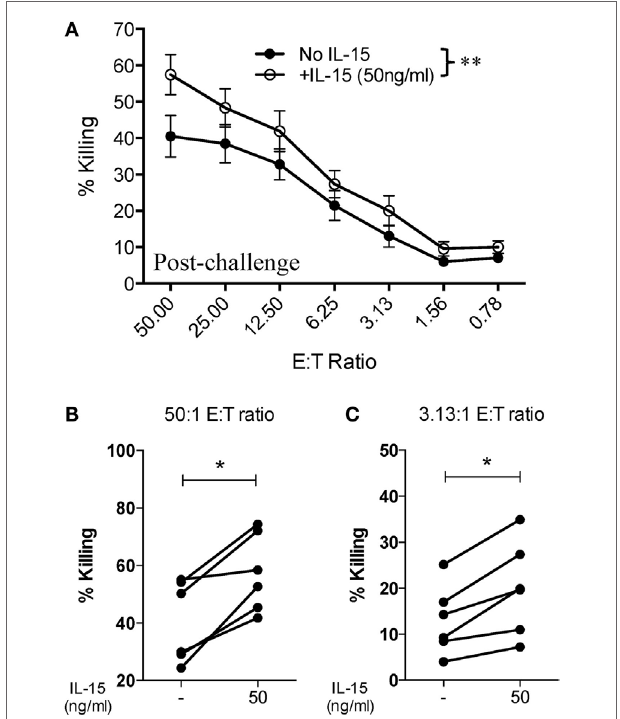
FigUre 4 | higher dose of il-15 pre-treatment is required to improve cytotoxic potential of nK cells from siV-infected macaques . Frozen PBMCs obtained from six macaques at 8 or 12 weeks post-challenge were thawed and cultured overnight in media alone or in media supplemented with 50 ng/ml of recombinant rhesus macaque IL-15 before being used in 721.221 killing assays. (a) Killing of 721.221 target cells by PBMCs from SIV-infected macaques pre-cultured with or without 50 ng/ml of IL-15. Data reported are means ± SEM. ** p < 0.01 indicates statistically significant differences between the indicated killing curves as determined by two-way ANOVA. (B,c) Impact of 50 ng/ml IL-15 pre-treatment on 721.221 target cell killing at either a high [50:1 (B) ] or low [3.13:1 (c) ] effector-to-target cell ratio. * p < 0.05 indicates statistically significant differences between the two compared conditions as determined by Wilcoxon matched-pairs signed-rank test.